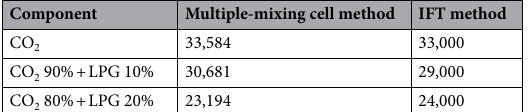
Table 3. MMP calculation results based on the multiple-mixing-cell and IFT methods (kPa).